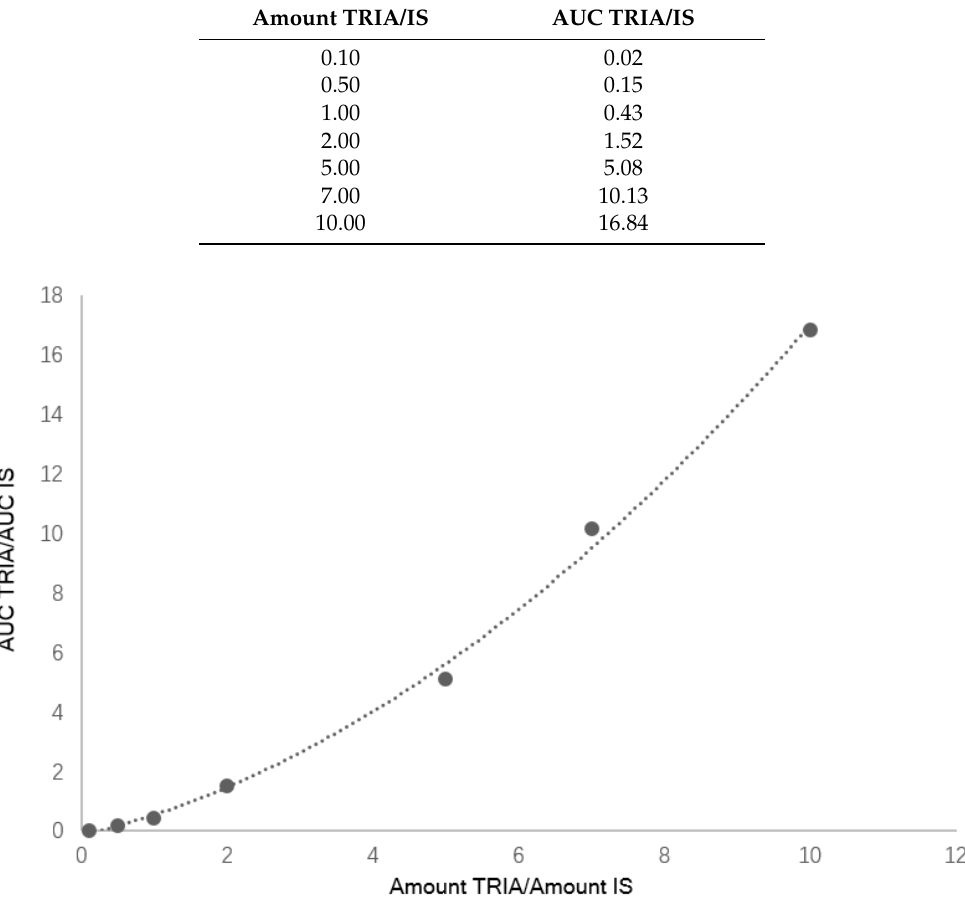
Table 1. Values used for the TRIA calibration curve.